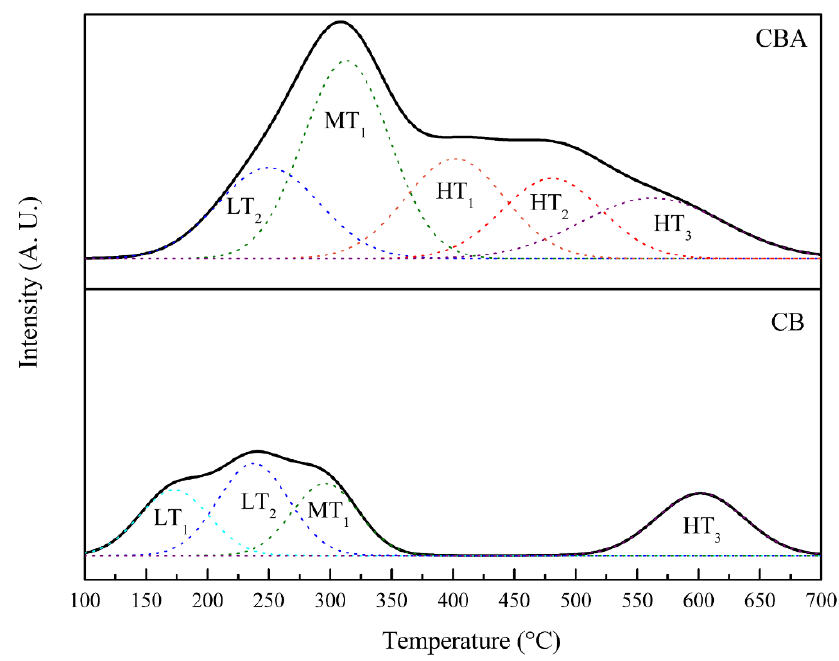
Figure 4. Ammonia desorption as a function of temperature for materials CB and CBA (solid lines) and individual components after deconvolution (dotted lines).